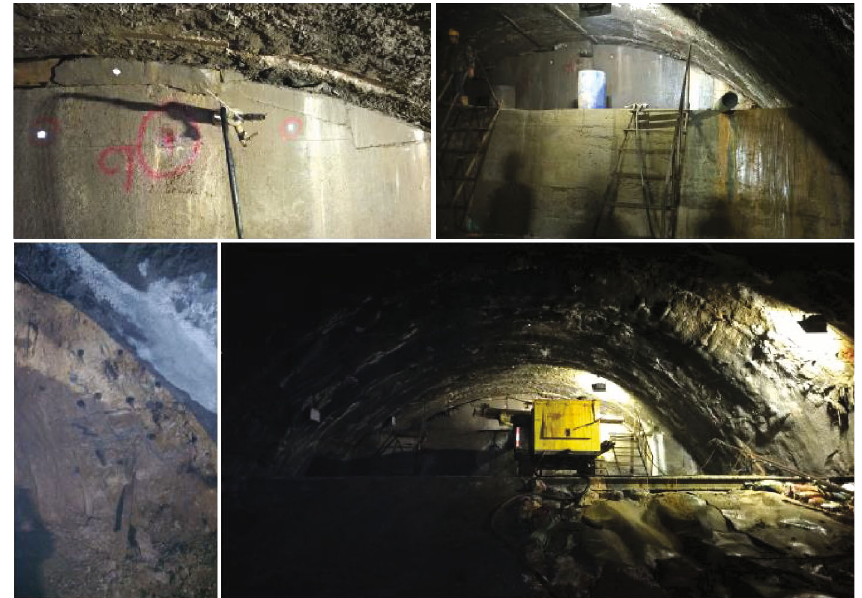
Figure 18: The situation after grouting. Table 4: Test results of supplementary